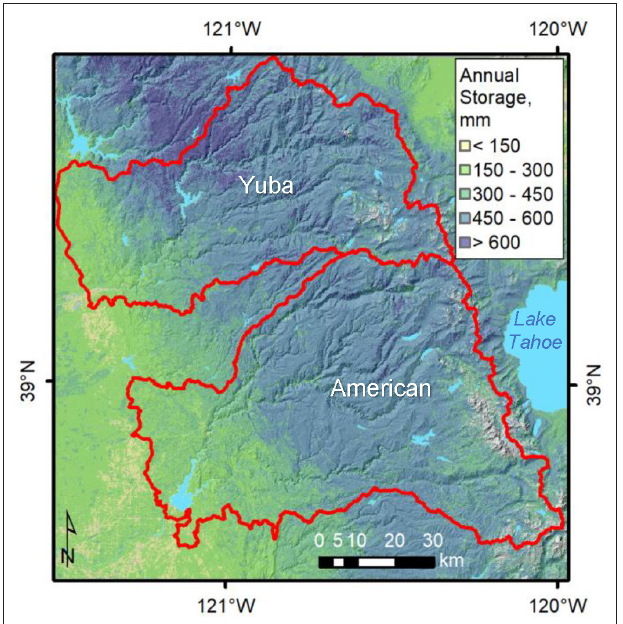
FIGURE 9 | Maximum cumulative (interannual) evapotranspiration supplied by subsurface water storage for the study period (1985–2018), which is the maximum accumulated negative value of annual P-ET. Dark and light gray areas indicate no data and lakes, respectively.